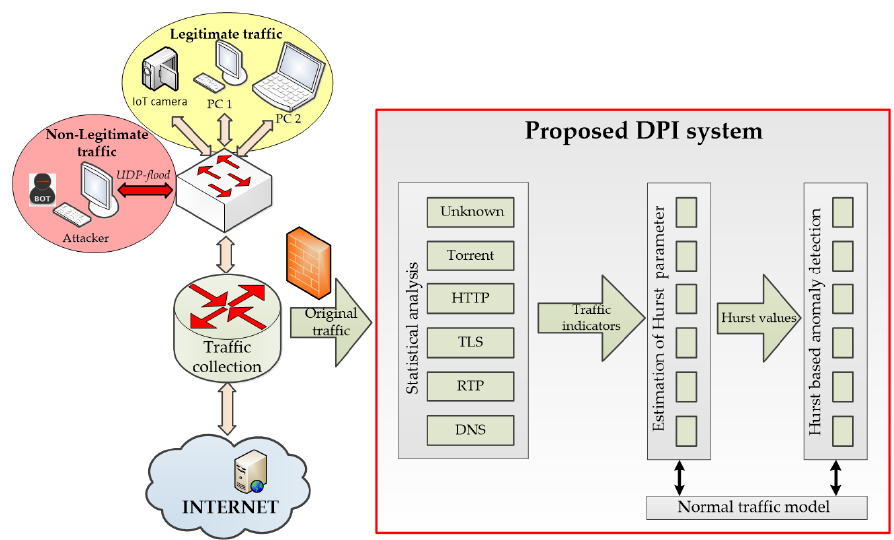
Figure 21. Network traffic analysis and anomaly detection scheme using the proposed DPI system.